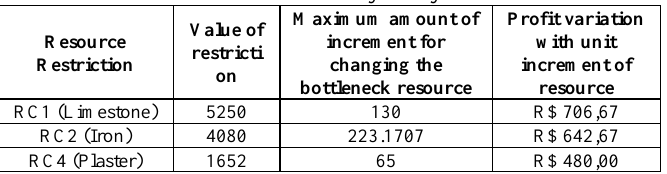
Table 4: Sensitivity